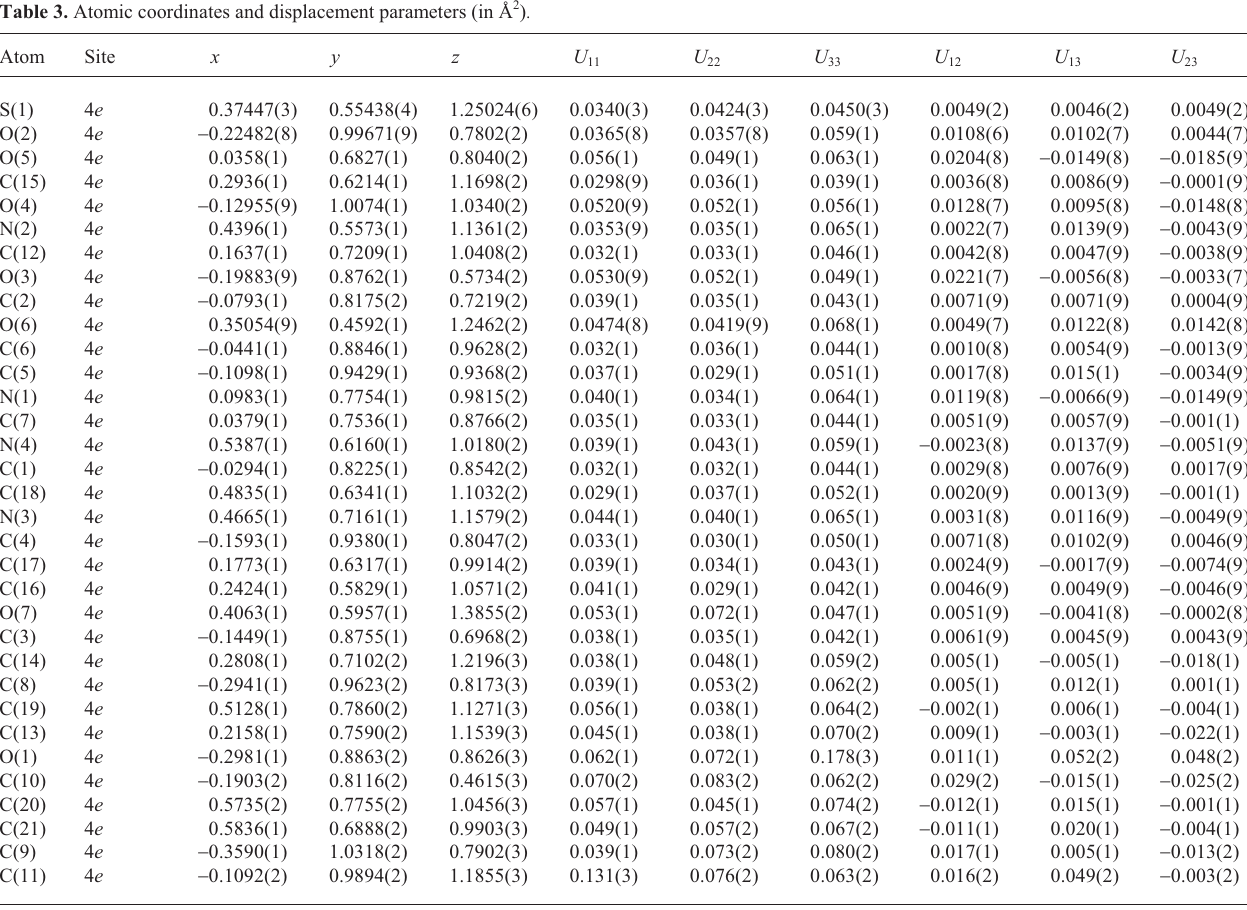
Table 3. Atomic coordinates and displacement parameters (in Å 2 ) .